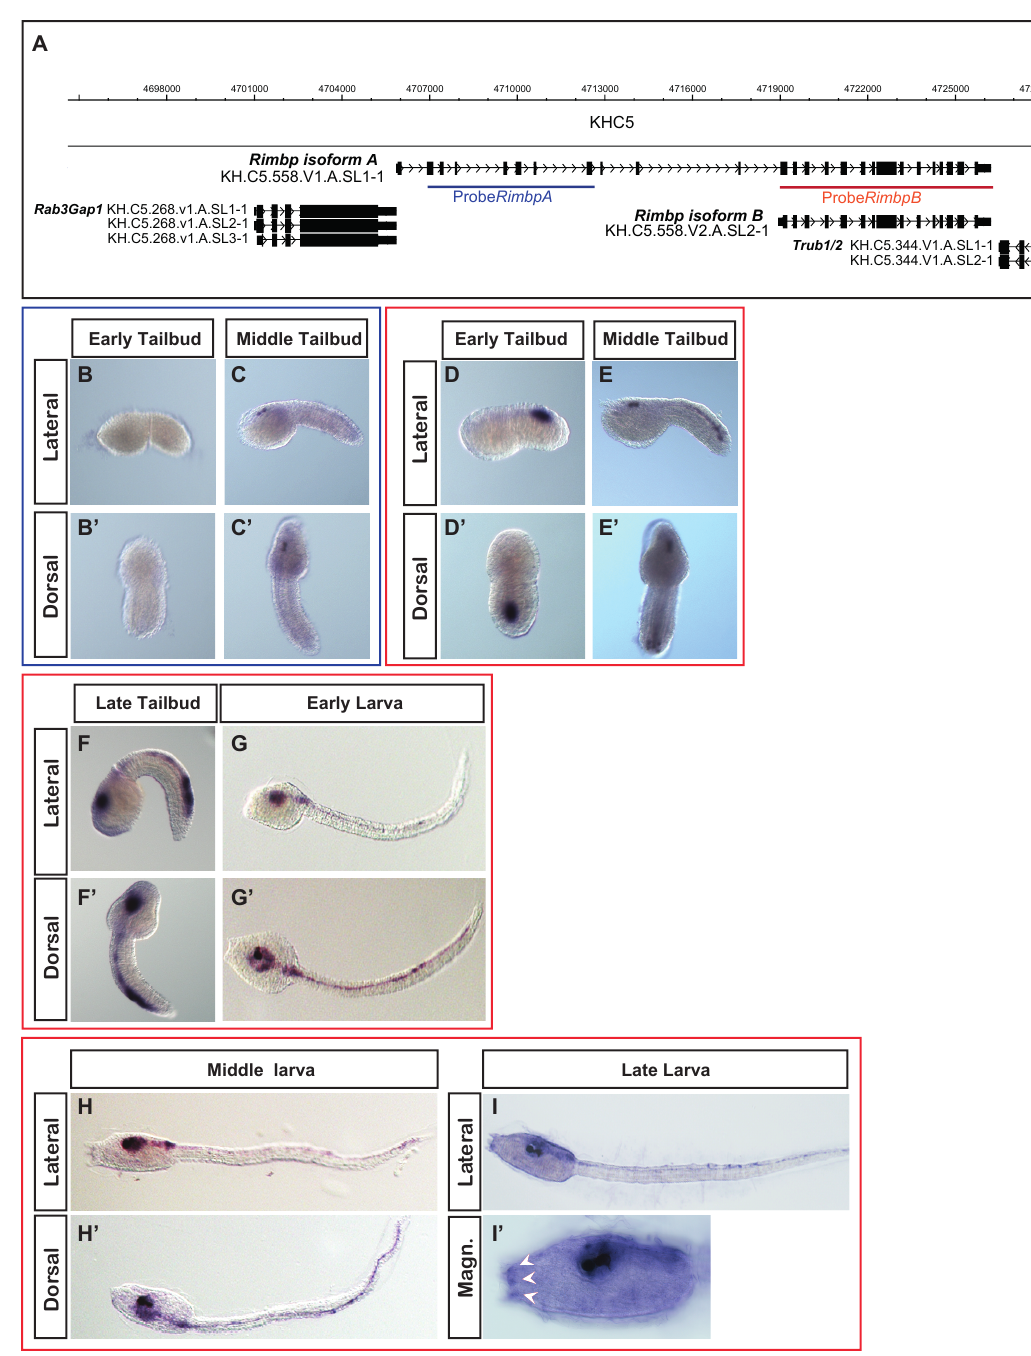
Figure 2. Ciona robusta Whole-mount in situ hybridization (WISH) of Rimbp . ( A ) Genomic organization of isoform A (blue) and isoform B (red) of Rimbp . ( B – C (cid:48) ): isoform A is expressed only in the sensory vesicle at the middle tailbud stage ( C , C (cid:48) ). ( D – I (cid:48) ) isoform B expression. At the early tailbud stage, this isoform is expressed in the posterior part of the developing nervous system ( D , D (cid:48) ) while from the middle to late tailbud, expands its expression in the sensory vesicle ( E – F (cid:48) ). At early and middle larva stages, isoform B is also expressed in the sensory vesicle and motor ganglion ( G – H (cid:48) ). At the middle and late larva, the isoform B starts to be expressed in the adhesive papillae organs (white arrowhead H – I (cid:48)